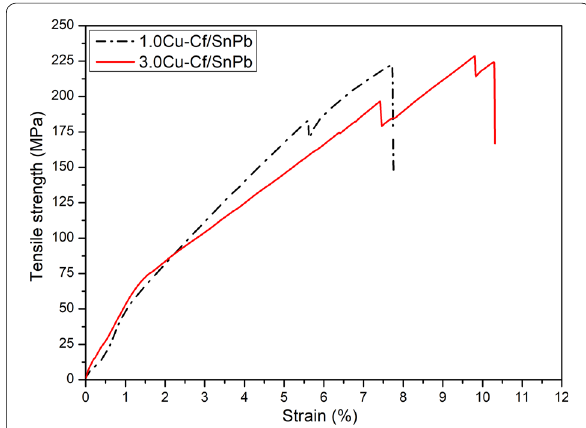
Figure 10 Typical tensile strength-strain curve of the printed composite specimens